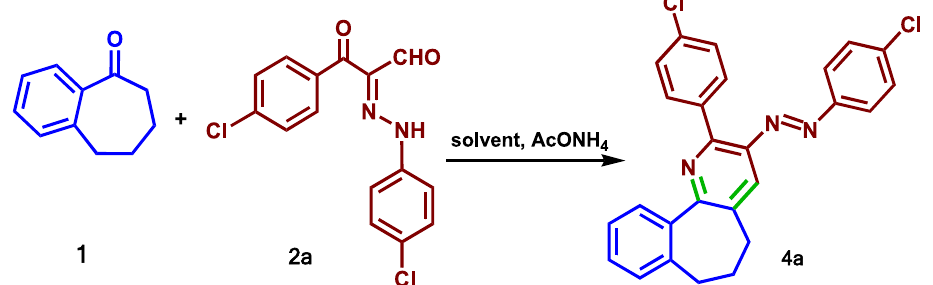
Table 1. Optimized reaction condition between benzosuberone 1 and arylhydrazonal 2a .